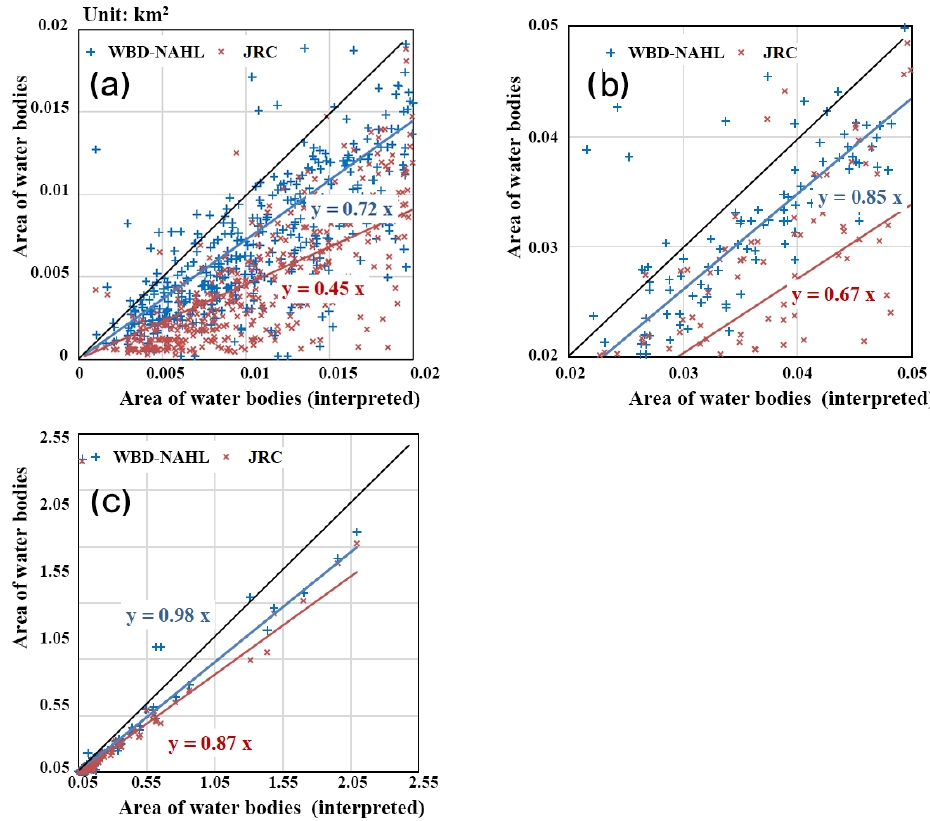
Figure 8. Comparisons of the water body area identified by the JRC, WBD-NAHL, and interpreted water maps. The 1 : 1 lines are in black. The red crosses represent the JRC water bodies, and the blue pluses represent the WBD-NAHL water bodies in comparison with the manually interpreted water bodies. The water bodies are compared in groups of sizes, i.e., (a) small water bodies with sizes < 0 . 02km 2 , (b) medium water bodies with sizes between 0.02 and 0.05km 2 , and (c) large water bodies with sizes > 0 . 05km 2 . The R 2 values for the WBD-NAHL and JRC identified water bodies were similar, i.e., 0.6 for small water bodies, 0.5 for medium water bodies, and 0.9 for large water